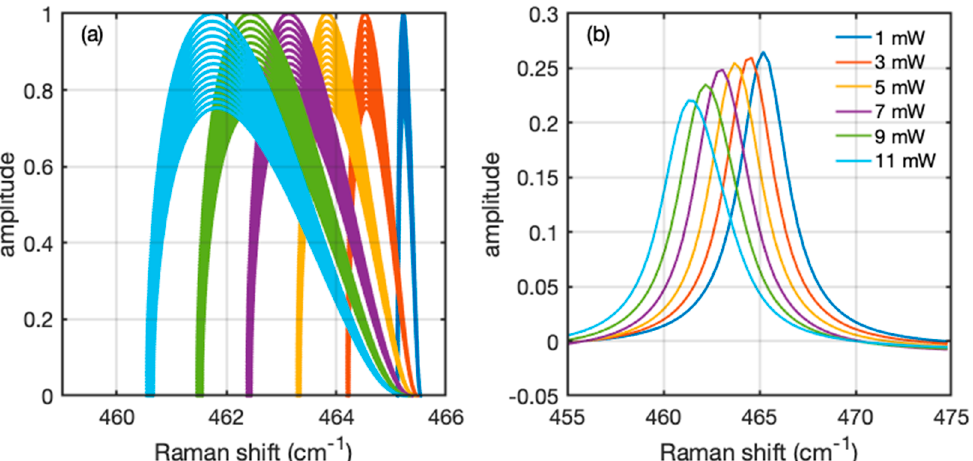
Figure 5. Simulation of the Raman spectrum from the distribution of temperatures. ( a ) Each point represents the wavenumber and the amplitude of the contribution of each finite element of the thermal simulation. Each color represents a different excitation power ranging from 1 to 11 mW, with the same color code as Figure 2. The distributions are normalized to each maximum amplitude. ( b ) Summation of all the infinitesimal spectra generated from the elements of ( a ), giving rise to spectra that can be compared to the experimental results. The spectra are normalized to their integrated intensity.